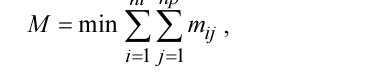
Fig. 1. Track layout influence on maintenance